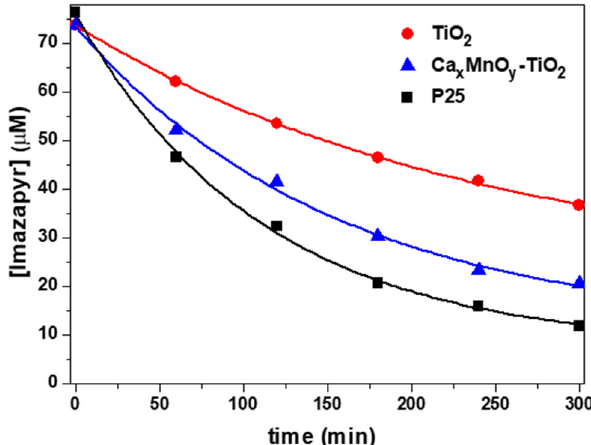
Figure 8. Change in Imazapyr concentration over time for TiO 2 -Hombikat UV 100 and Ca x MnO y -TiO 2 under UV-Vis irradiation, as determined by HPLC monitoring.